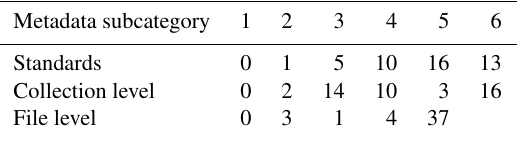
Table 2. Frequency of occurrence of the maturity matrix scores for the three subcategories (standards, collection level, file level) of the main category metadata. Note that file level does not use the score category